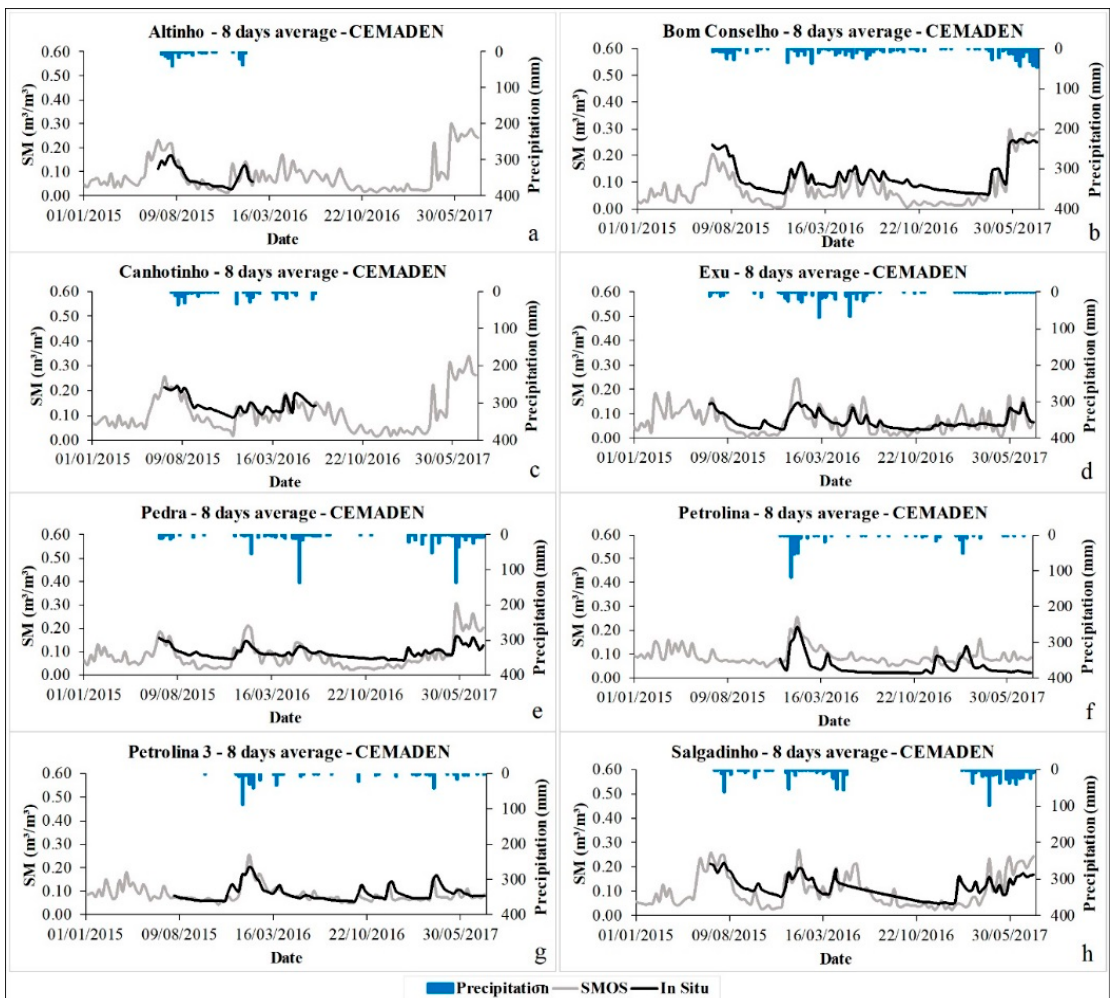
Figure 6. Eight-day average soil moisture from CEMADEN stations, SMOS data, and measured precipitation for the period of July 2015 to July 2017. Each graph refers to a station.